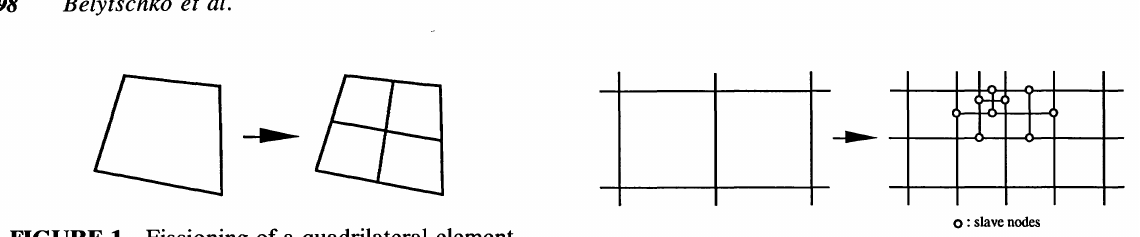
FIGURE 1 Fissioning of a quadrilateral element.